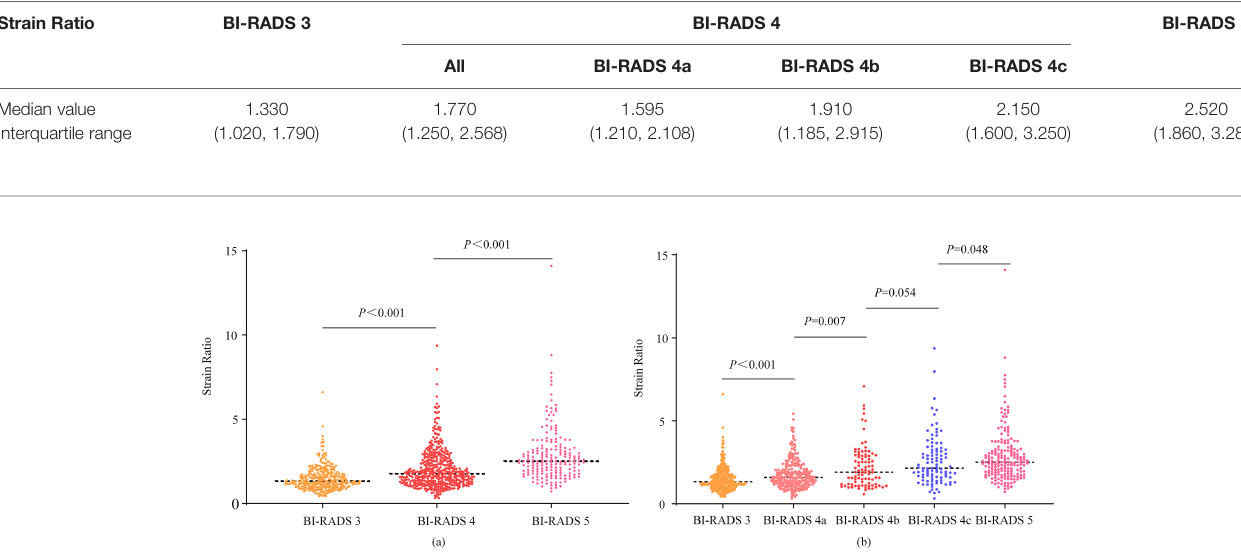
TABLE 3 | The strain ratio in different BI-RADS classi fi cations.